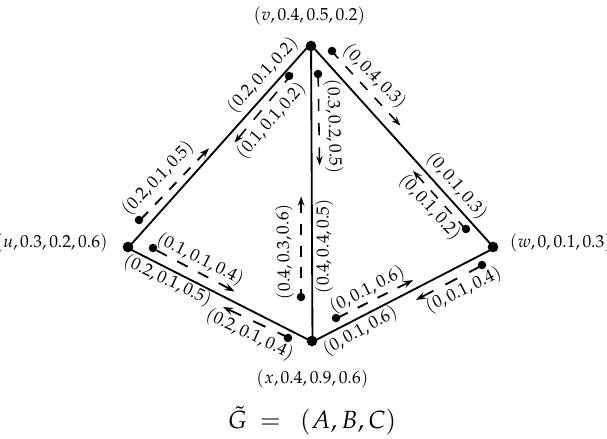
Figure 4. Single-valued neutrosophic incidence